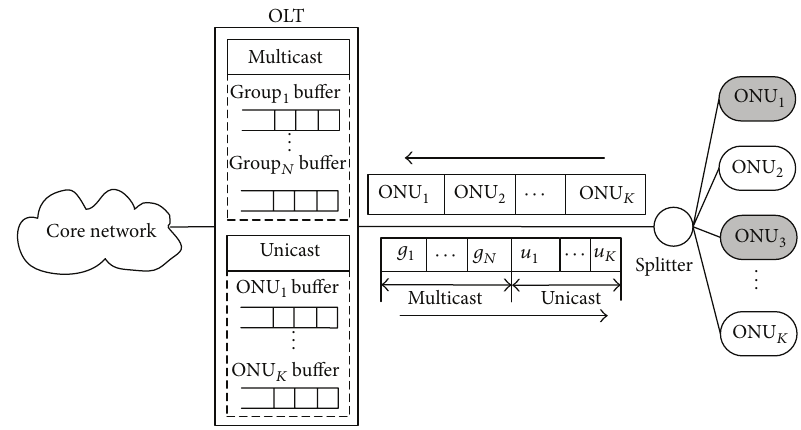
Figure 1: EPON multicast and unicast traffic